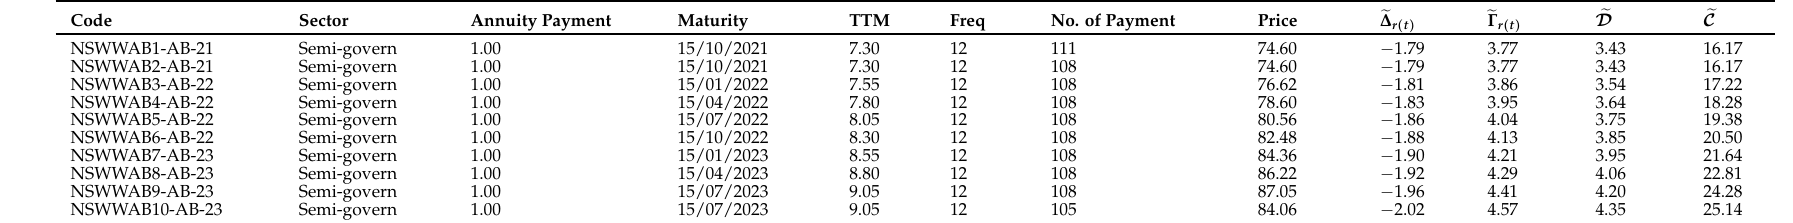
Table 9. These are annuity bonds with monthly payments. Terms to maturity are relatively short compared to the coupon paying bonds with a maximum of around 9 years. Fisher-Weil durations are between 3 and 5 years. Interest rate deltas do not vary much. Similar comments apply to interest rate gamma and Fisher-Weil convexity. Since the life annuity is assumed to have monthly payments these annuity bonds have the potential to better match the cash flows for the liability but suffer from having short